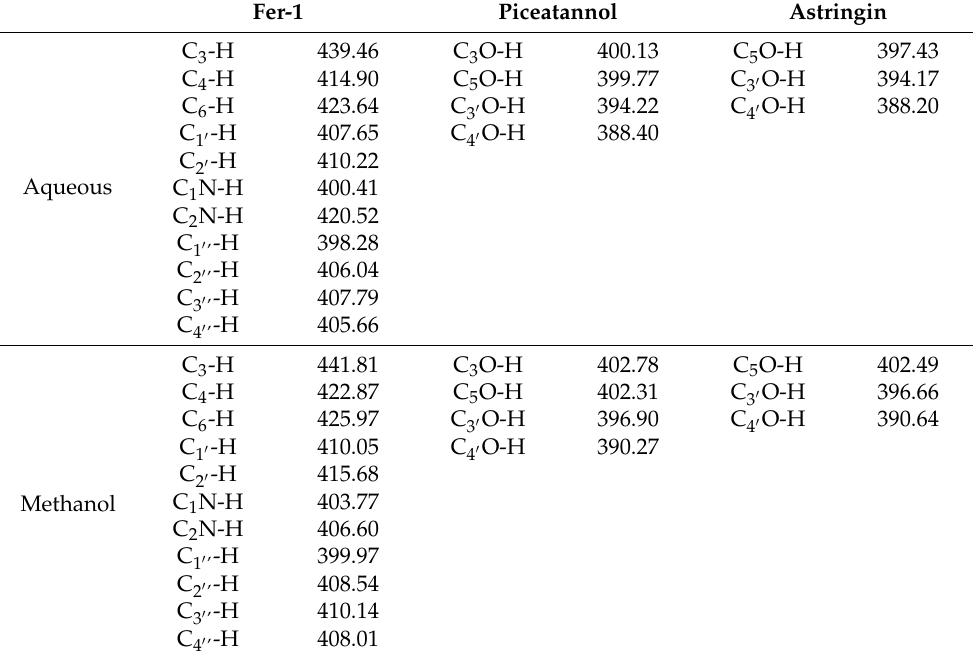
Figure 4. Optimized molecular model with IP value and isosurface map of electron density difference between neutral molecules and cationic radicals ( A , Fer-1; B , piceatannol; C, astringin) in the aqueous SMD solvation model. The calculations were based on M06-2X-D3/6-311+G** and M06-2X-D3/def2- TZVPD calculation levels. In the isosurface map, lime and purple colors correspond to the regions where the electron density increased and decreased, respectively (isovalue = 0.008). The Cartesian coordinates and energies of the optimized neutral molecules are listed in Supplementary Material 2. Table 2. The BDE values (kcal/mol) of Fer-1, piceatannol, and astringin in aqueous and methanol so-